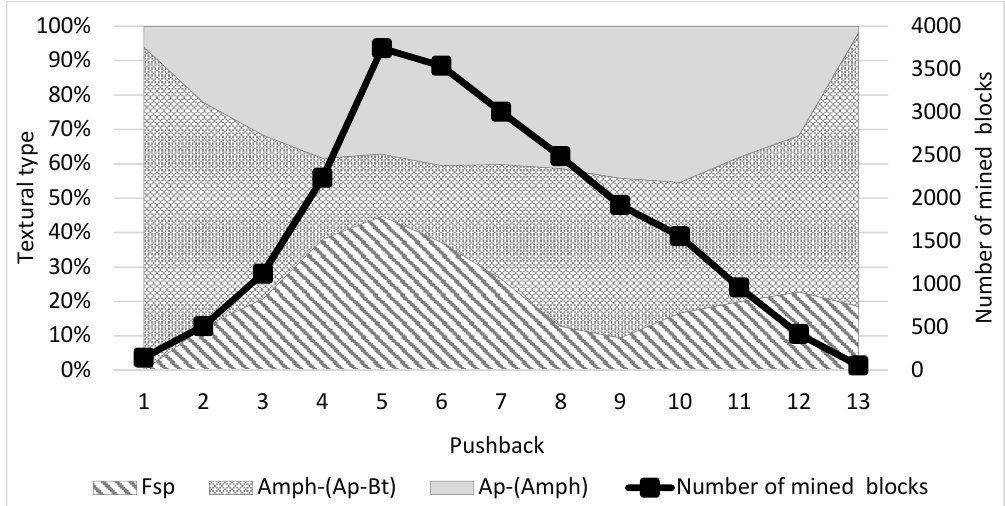
Figure 11. Feed forecast generated from the mining model.